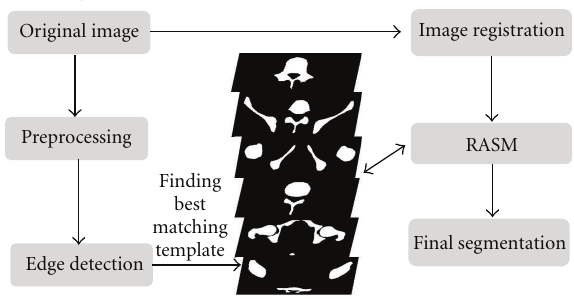
Figure 2: Schematic diagram of pelvic bone